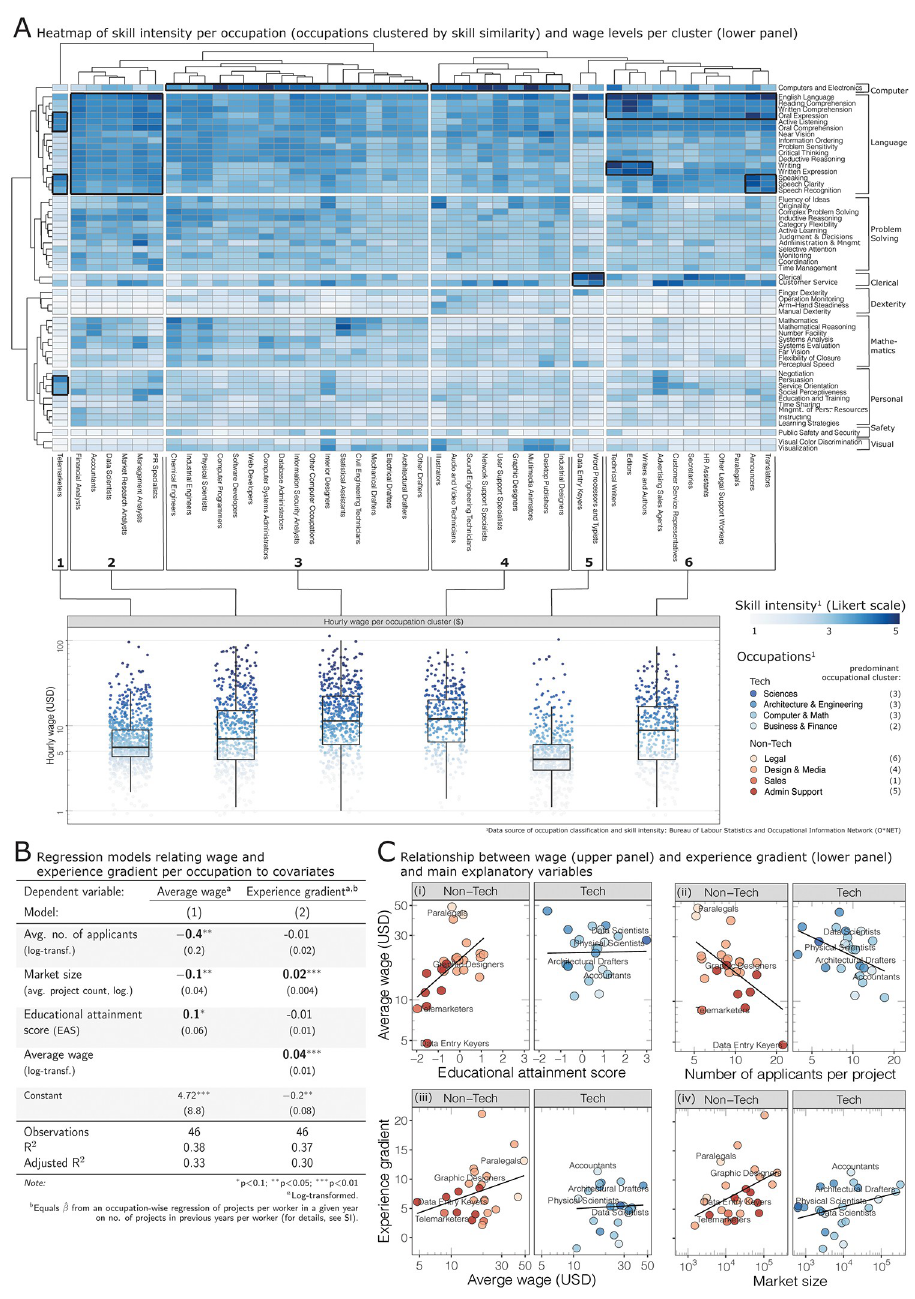
Fig 3. ( A ) Heatmap of skill intensity per occupation (upper panel) and wages per occupation cluster (lower panel): occupations (columns) with similar skill intensities (rows) cluster together; the highest paying occupations require computer-related know-how or English language comprehension and writing; lower-paying occupations focus on clerical skills, personal and oral communication. ( B ) Regression models between hourly wage (model 1), experience gradient (model 2) and occupation-level covariates: occupations with less competition (fewer applicants per job and lower avg. project count) and higher educational requirements pay higher average wages; previous experience counts more in high-paying occupations with fiercer competition (high project count). ( C ) Relations between wage (upper panel), experience gradient (lower panel) and occupation-level covariates: platform workers with only a fewer previous projects find it hard to be hired in non-tech occupations (panel